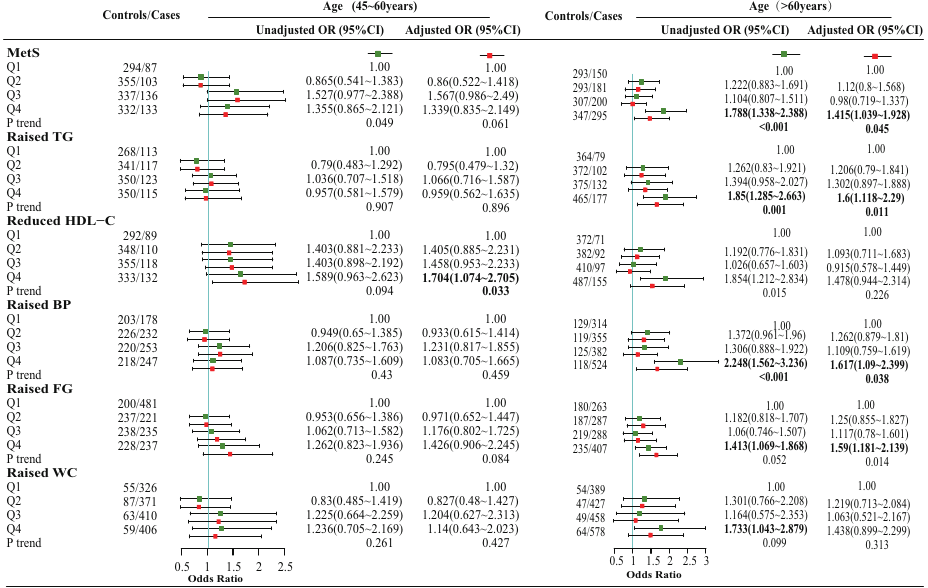
Figure 5. Subgroup analysis of association between DII and MetS as a whole and its components among different age groups. Adjusted for confounding factors such as age, gender, race, education, poverty − income ratio, smoking, alcohol consumption, and sedentary behavior. Q1 [ − 5.21, − 1.10), Q2 [ − 1.10, 0.60), Q3 [0.60, 2.09), Q4 [2.09, 4.23) for the age range of 45 to 60 years; Q1 [ − 4.71, − 0.89), Q2 [ − 0.89, 0.66), Q3 [0.66, 1.99), Q4 [1.99, 4.66) for age over 60